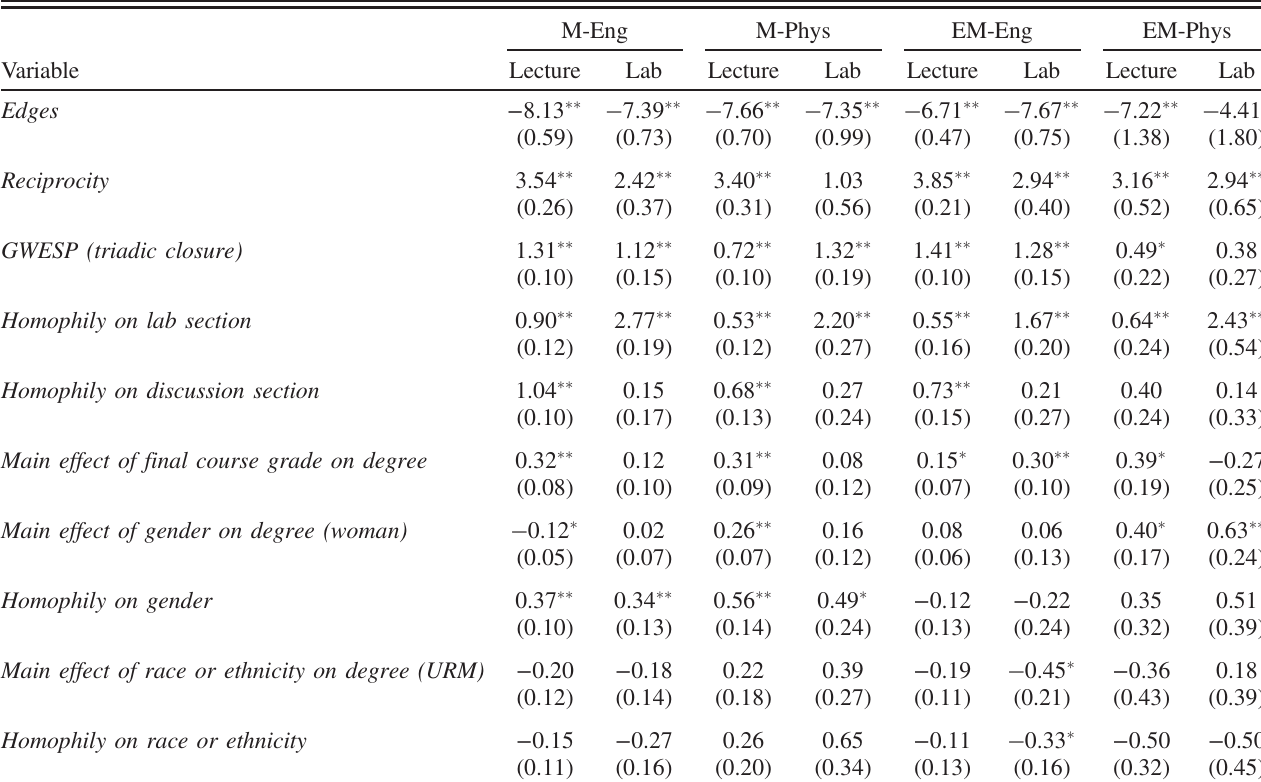
II. Coefficient estimates for our ERGM fit to the four observed courses (eight observed networks). Standard errors of the coefficient estimates are in parentheses below. Asterisks indicate statistical significance ( (cid:1) p < 0 . 05 ; (cid:1)(cid:1) p < 0 . 01